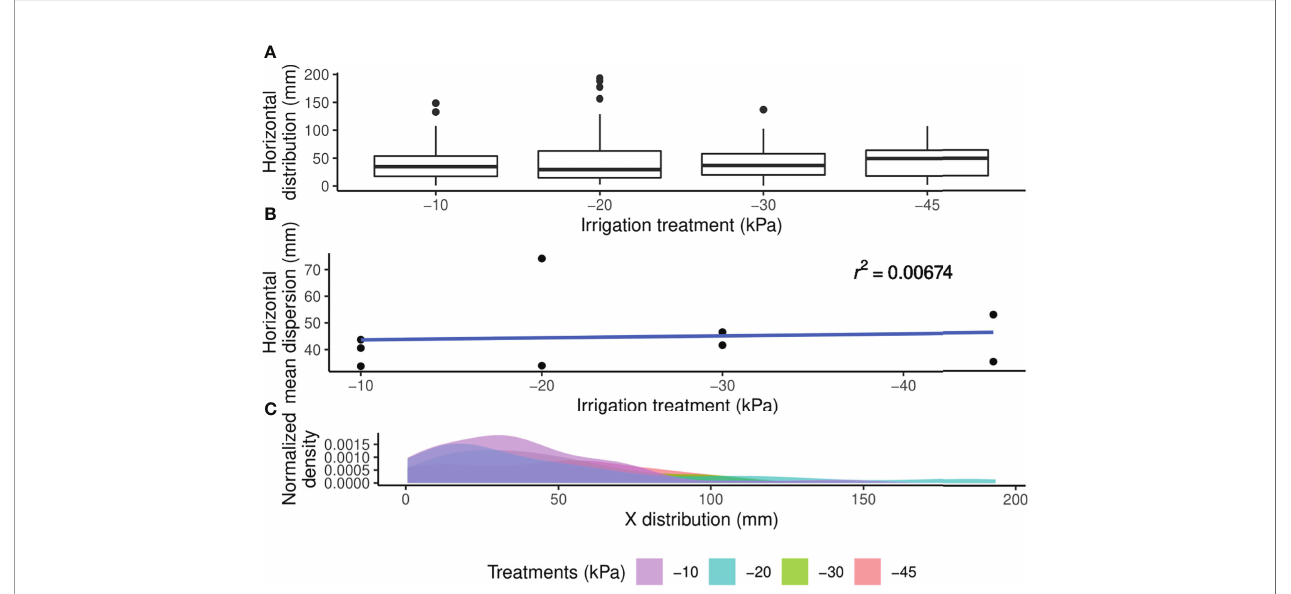
FIGURE 4 | (A) Horizontal distribution of tubers in mm for each irrigation treatment. (B) Mean horizontal distance of the tubers in each unit (indicated by points) from the experimental unit center for each irrigation treatment. The blue line represents the linear regression across all the treatments. (C) Horizontal distribution of tuber density grouped by irrigation